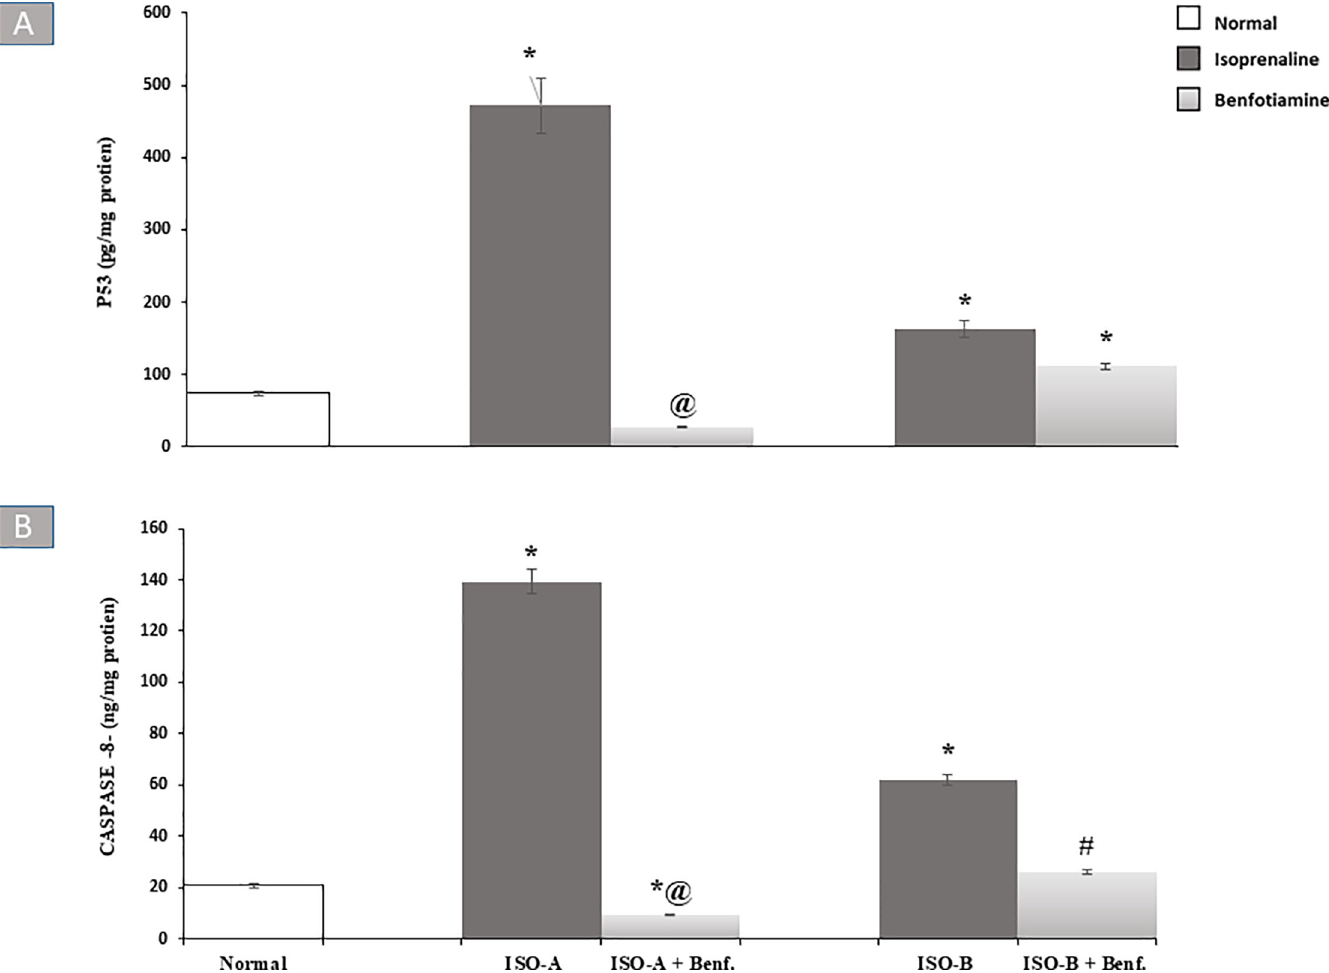
Fig 4. Effect of benfotiamine pre- and post-treatments on myocardial (A) p53 and (B) caspase-8- contents in ISO-induced MI in rats. Each bar represents mean ± SEM (n = 8). Statistical analysis was done using One-way ANOVA followed by Tukey’s post-hoc test. � significantly different from the normal group at p < 0.05. @significantly different from the ISO-A group at p < 0.05. #significantly different from the ISO-B group at p < 0.05. ISO-A: ISO pre-treatment control; ISO-B: ISO post-treatment control; ISO-A+ Benf.: benfotiamine prophylactic; ISO-A+ Benf.: benfotiamine treatment.